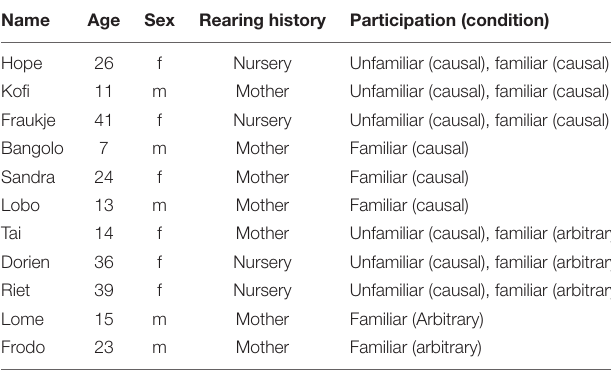
TABLE 3 | The name, age, sex, rearing history and information about experiment participation of chimpanzees ( N = 11).